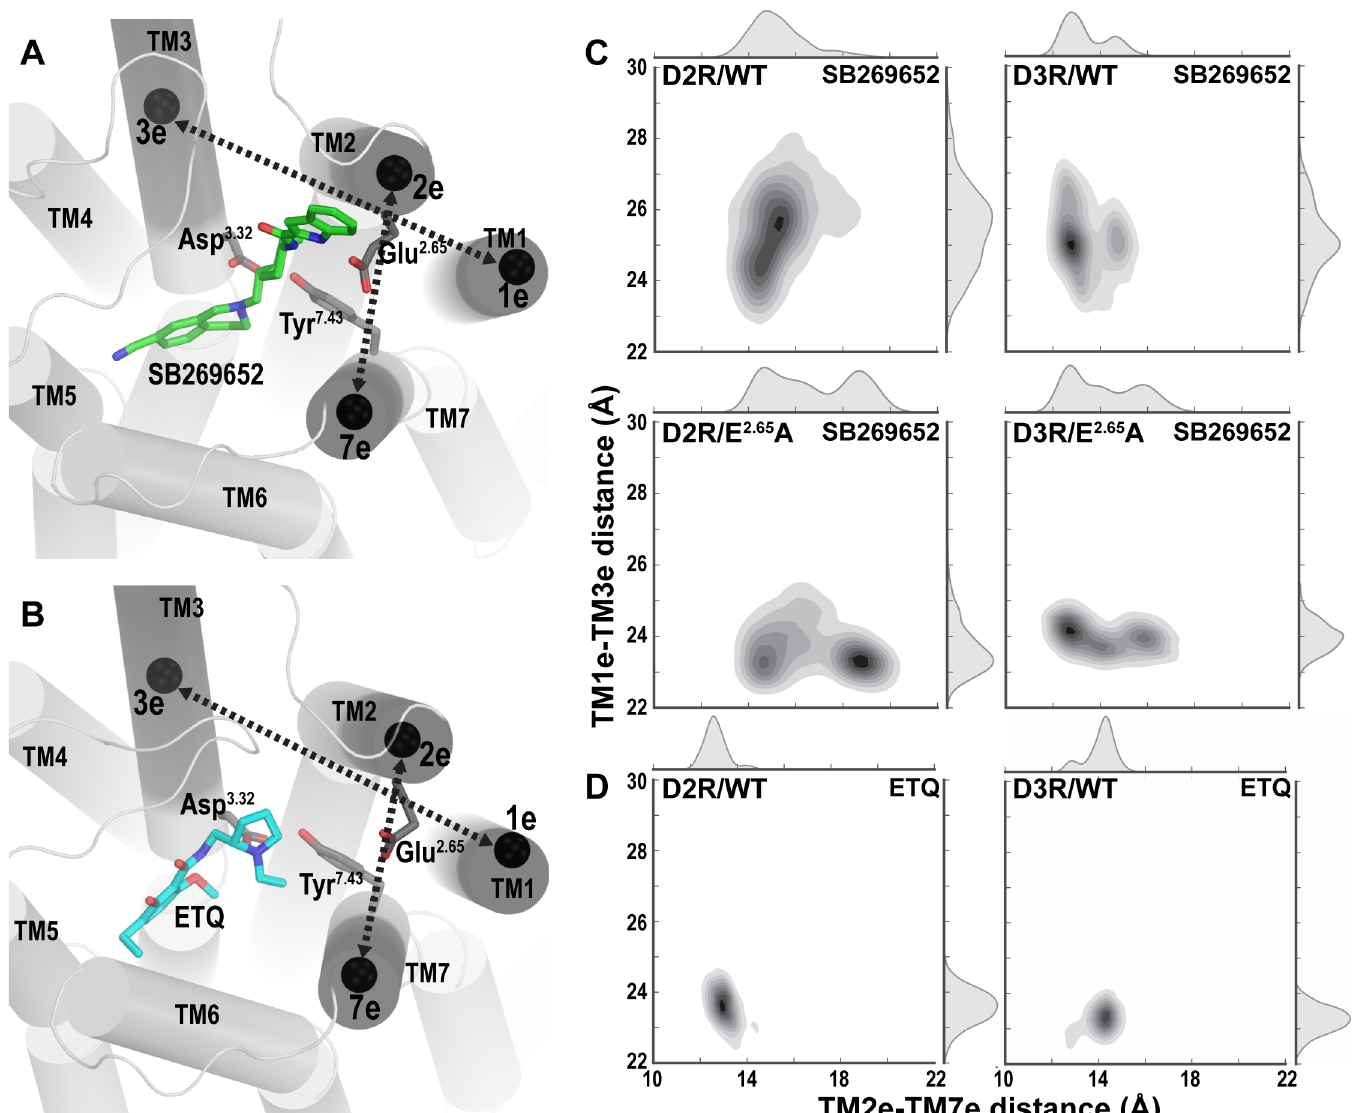
Fig 4. Comparative conformational analysis shows significant changes induced by E 2.65 A in the SBP. The SBP is occupied in the presence of SB269652 ( A ) but not eticlopride (ETQ, B ), and is enclosed by the TM subsegments TM1e, TM2e, TM3e, and TM7e. The centers of mass for each of these TM subsegments are shown as black spheres. Black dashed arrows indicate the distances measured in ( C ) and ( D ) for two TM subsegment pairs. The molecular graphics was generated using PyMOL (version 1.7.6.5, Schro¨dinger, LLC). ( C ) Distributions of distances between TM2e-TM7e are plotted against those of TM1e-TM3e distances for all the SB269652-bound conditions, showing larger TM2e-TM7e distances and smaller TM1e-TM3e distances in the E 2.65 A conditions of both receptors. ( D ) The distributions of these distances for the ETQ- bound conditions, when the SBP is not occupied. The MD simulation data of the ETQ-bound conditions were taken from